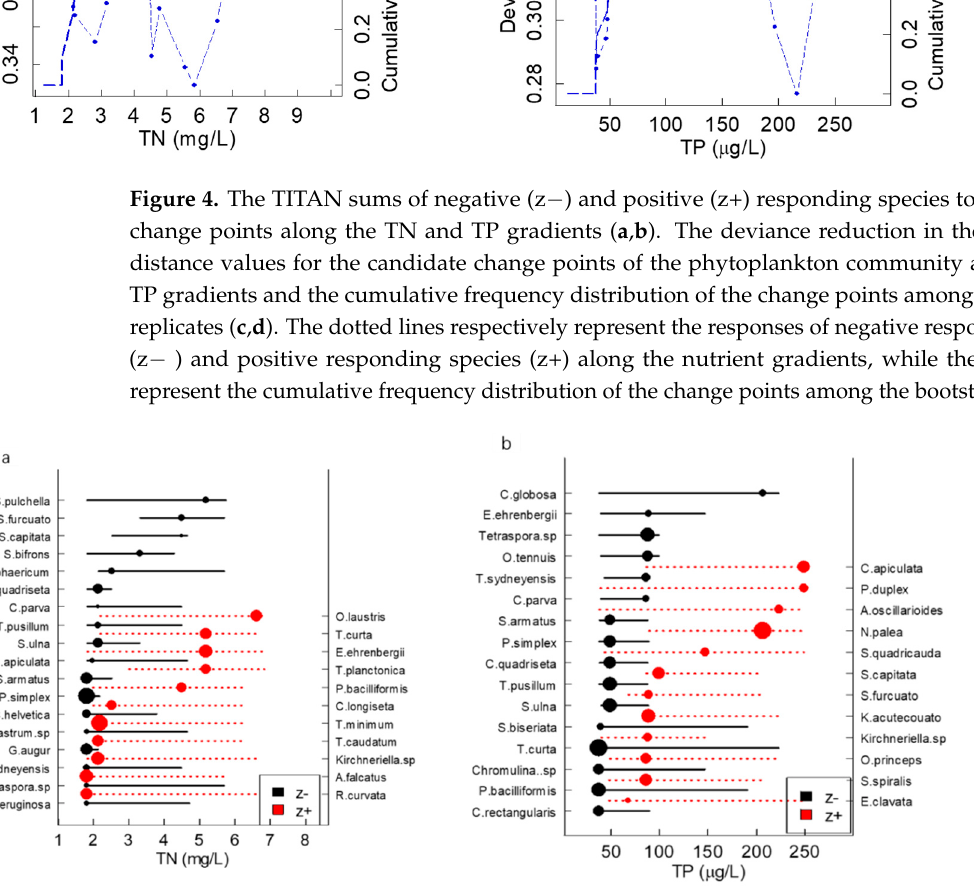
Figure 4. The TITAN sums of negative (z − ) and positive (z+) responding species to all candidate change points along the TN and TP gradients(a,b). The deviance reduction in the Bray–Curtis distance values for the candidate change points of the phytoplankton community along TN and TP gradients and the cumulative frequency distribution of the change points among the bootstrap replicates(c,d). The dotted lines respectively represent the responses of negative responding species (z − ) and positive responding species (z+) along the nutrient gradients, while the broken lines represent the cumulative frequency distribution of the change points among the bootstrap replicates. (a) title; (b) title; (c) title; (d) title.